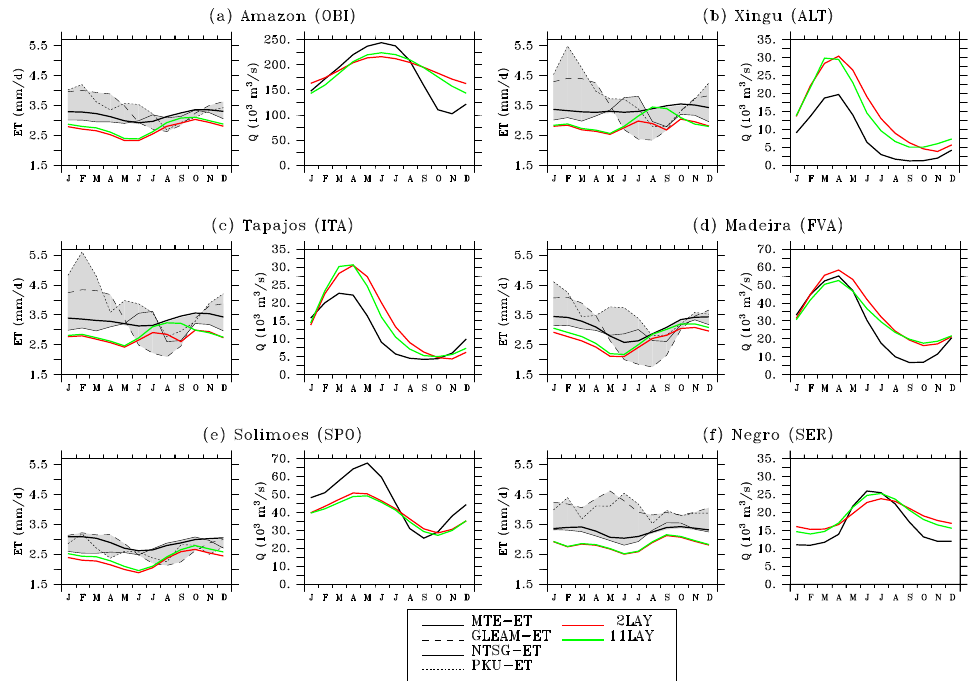
Figure 6. Monthly mean seasonal ET averaged over the different sub-basins (mmd − 1 ) and river discharge at the gauging stations (m 3 s − 1 ), from the 2LAY and 11LAY simulations compared to the observations, averaged over the period 1980–2008. The envelope (in gray) defines the spread existing between the four ET products for each